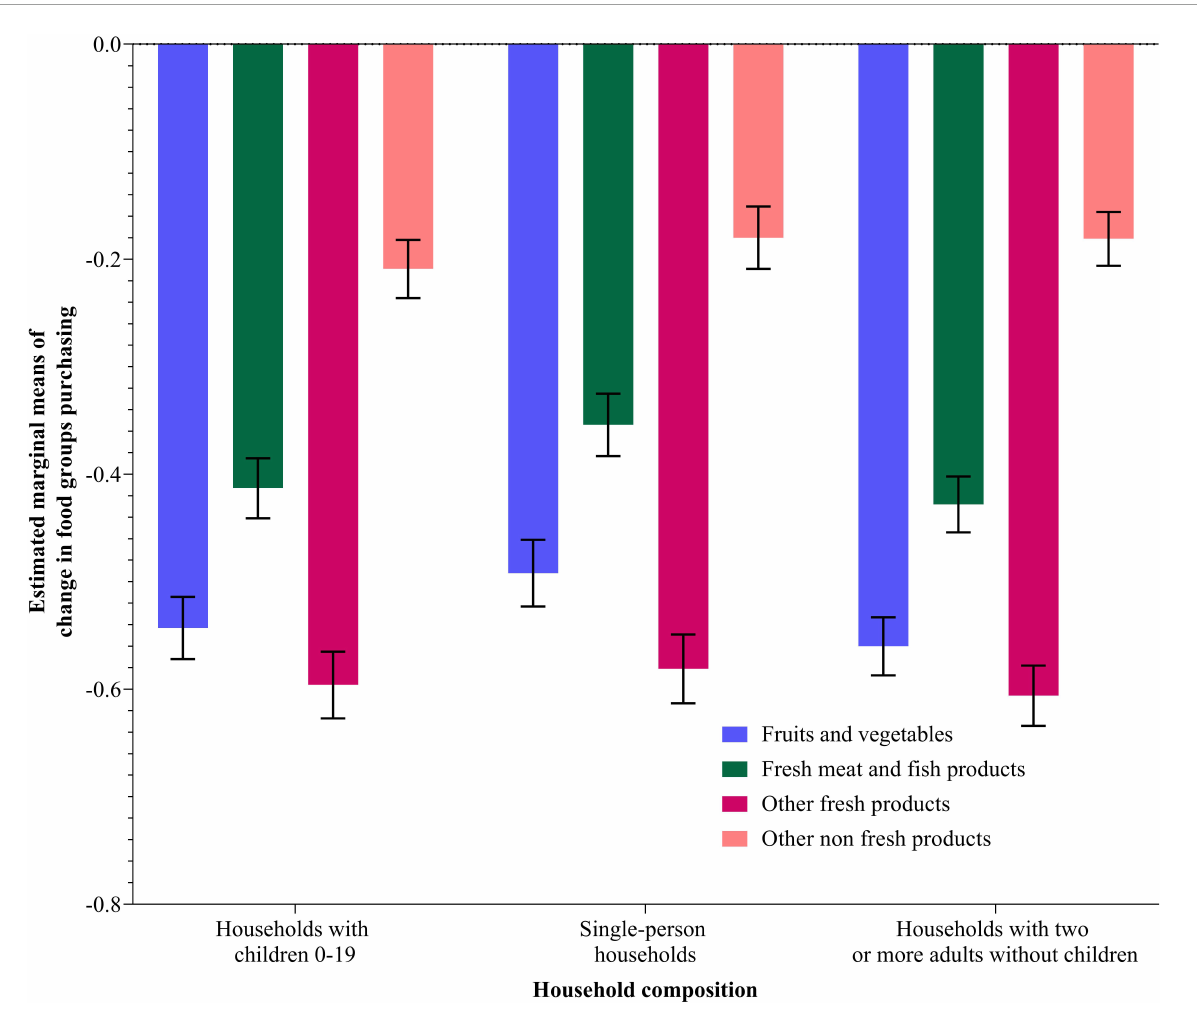
FIGURE5 Estimated marginal means using MANOVA procedure for different food types purchasing change (During—Before COVID-19) per household composition categories. Data weighted by countries (see also Supplementary Table 3